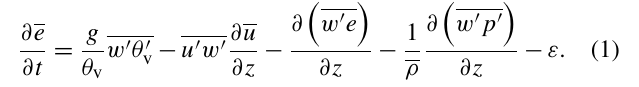
ERA5 reanalysis data, we calculate the buoyancy term (BT) (cid:16) (cid:17) g/θ v w (cid:48) θ (cid:48) and shear term (ST) v